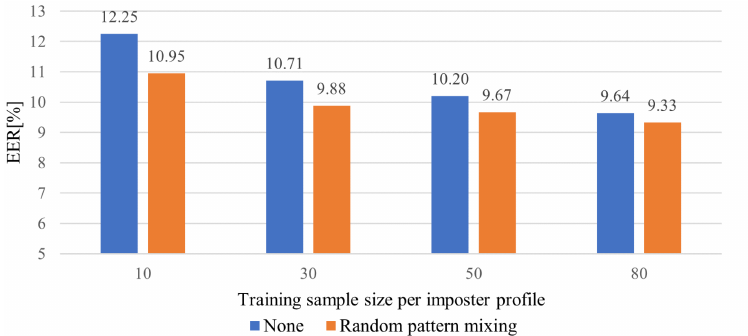
Figure 8. Averaged EERs ( % ) for different training sample sizes per impostor profile.